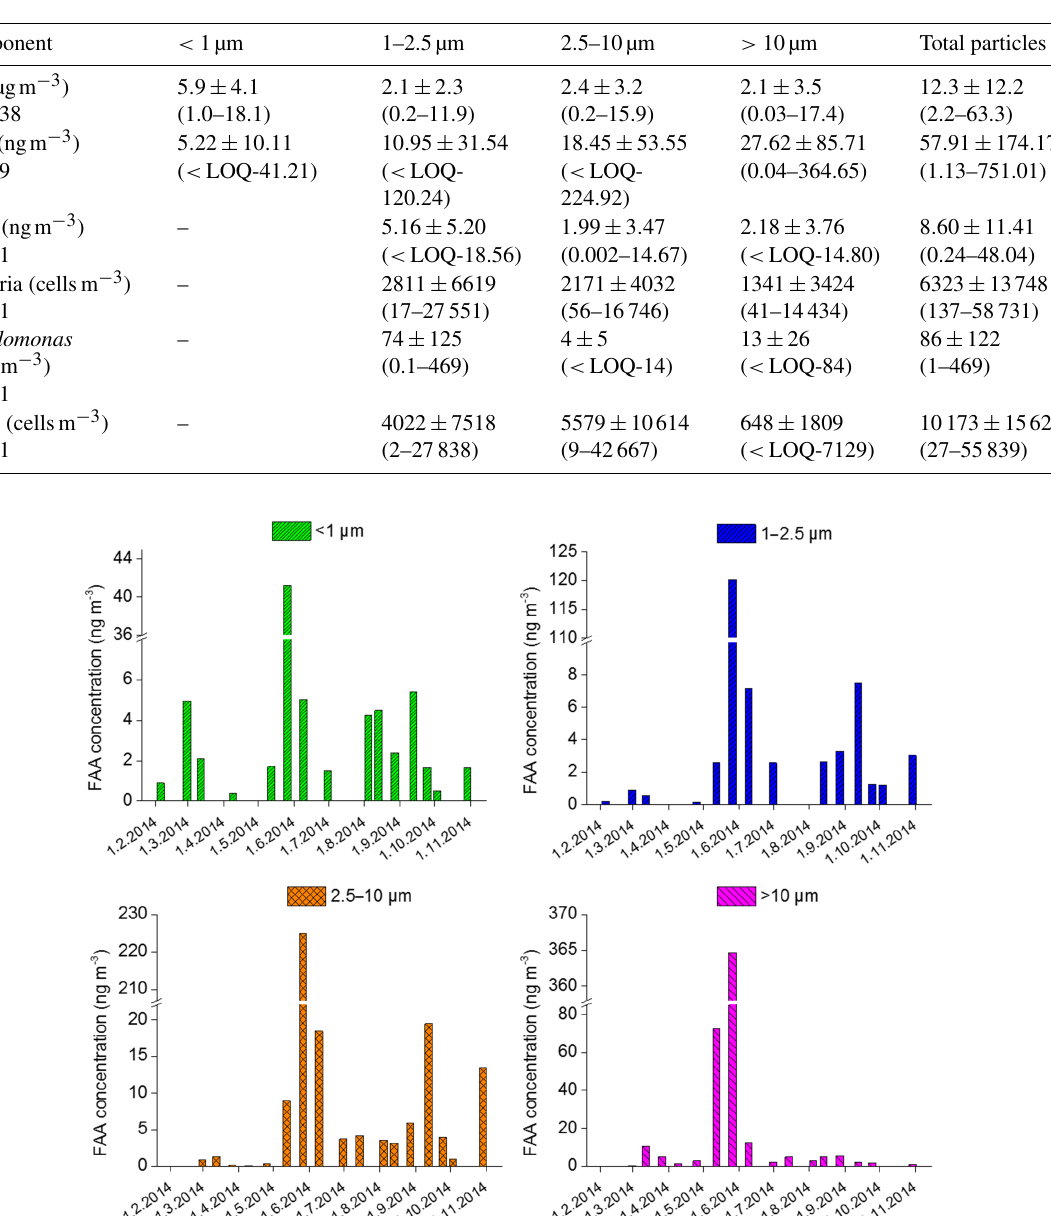
Table 1. Average ( ± SD) concentration and range of each component measured and the number of filter samples ( n ) analysed in total.